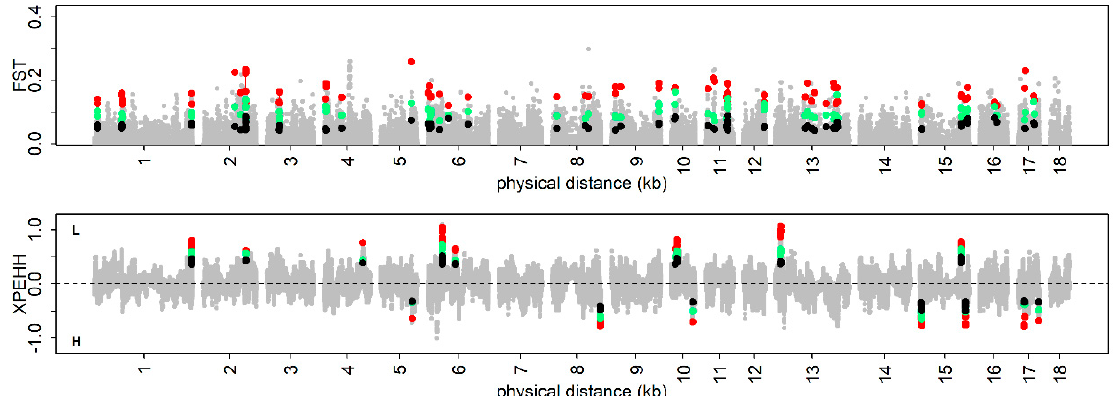
Figure 4. Visualization of trait-specific selection signatures for shoulder subcutaneous fat thickness (BF1). The colored dots indicate the trait-specific selection signatures. The black (green, red) dots indicate the selection signatures identified in 1st (2nd and 3rd) population pair. XPEHH: the Cross Population Extended Haplotype Homozogysity, F ST : the Wright’s fixation index.